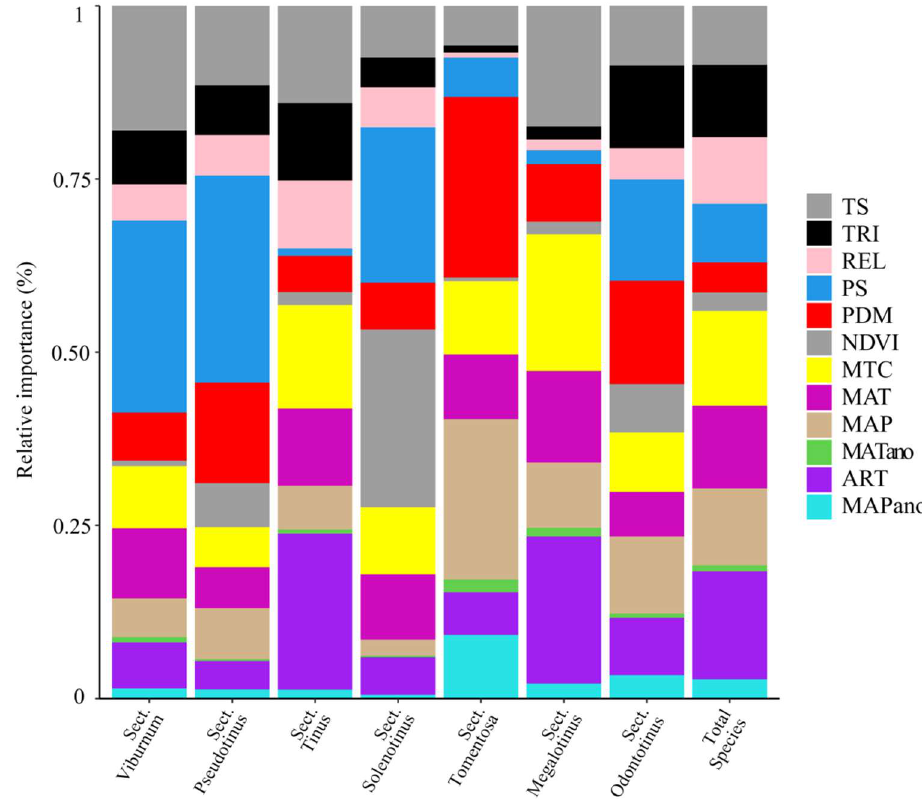
Figure 6. The relative importance of each explanatory factors for the richness of seven Sections of endemic taxa of genus Viburnum in China.